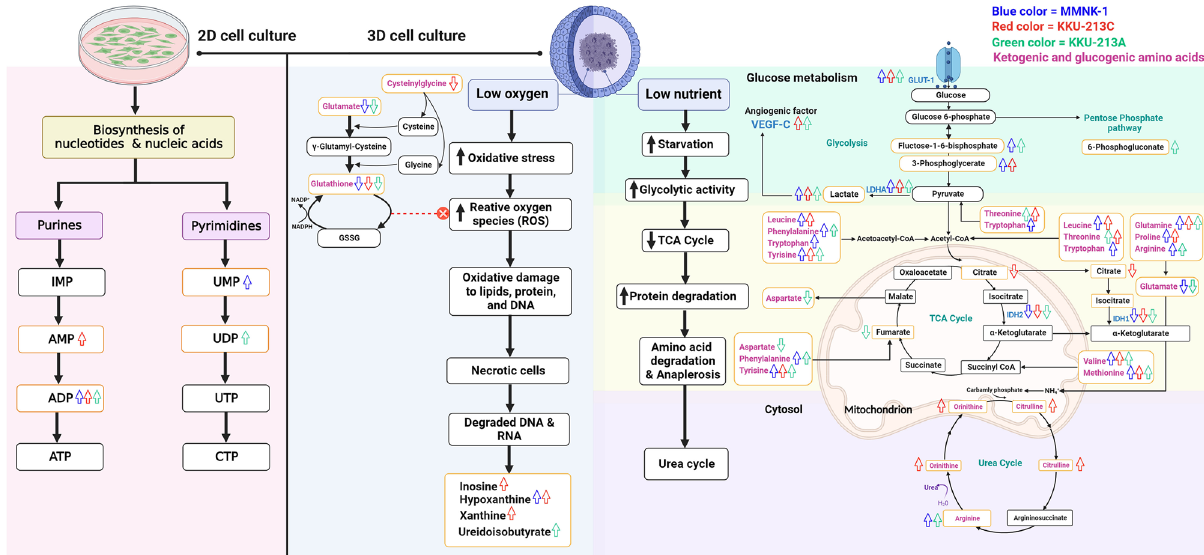
Figure 7. The proposed schematic of influenced pathways in 2D culture and 3D MCS . The up and down arrows represent the increased amount and decreased amount, respectively. Metabolites or proteins related to MMNK-1, KKU-213C, and KKU-213A represent in blue, red, and green colors. The illustration was created with